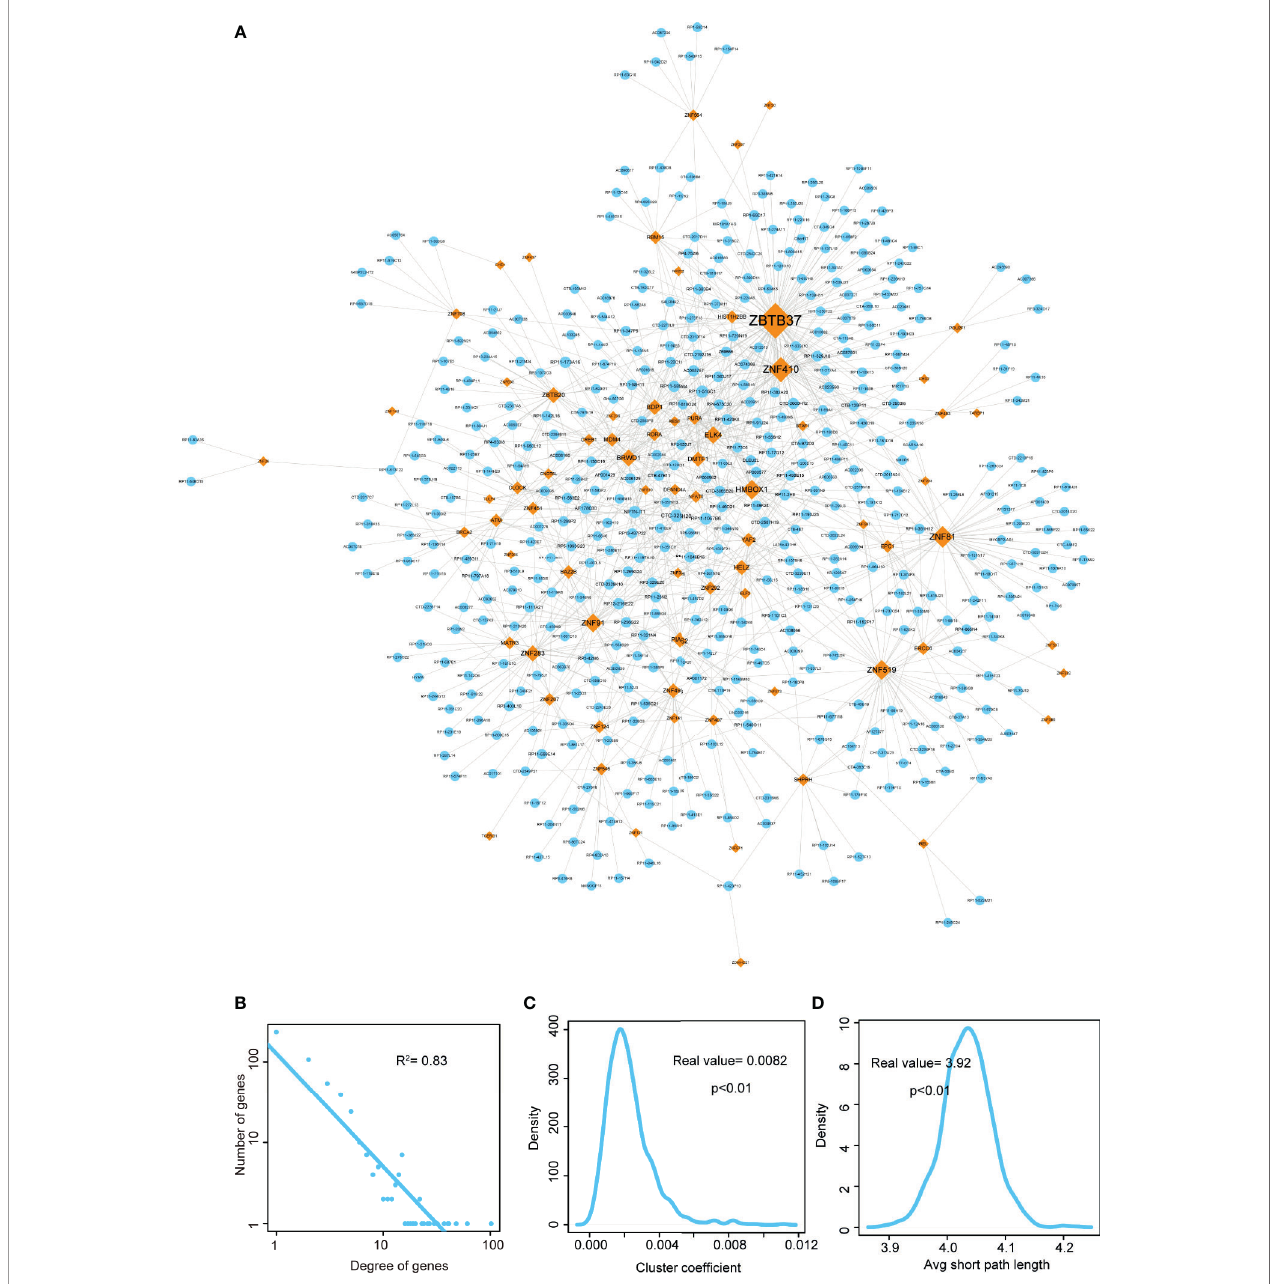
FIGURE 2 | Visualization and topological features of LUAD-related lncRNA-TF network. (A) Cytoscape network visualization of LUAD-related lncRNA-TF network. LncRNA nodes are represented in orange, and TF nodes are represented in blue. Network node degrees are represented by node size. (B) Degree distributions of the LUAD-related lncRNA-TF network. (C) Cluster coef fi cient distributions of LUAD-related lncRNA-TF network and 1,000 times permutation networks. Cluster coef fi cient of LUAD-related lncRNA-TF network was larger than in permutation cases (p-value < 0.01). (D) Average short path lengths of LUAD-related lncRNA-TF network and 1,000 times permutation networks. Average short path length in real network was smaller than in permutation cases (p-value <